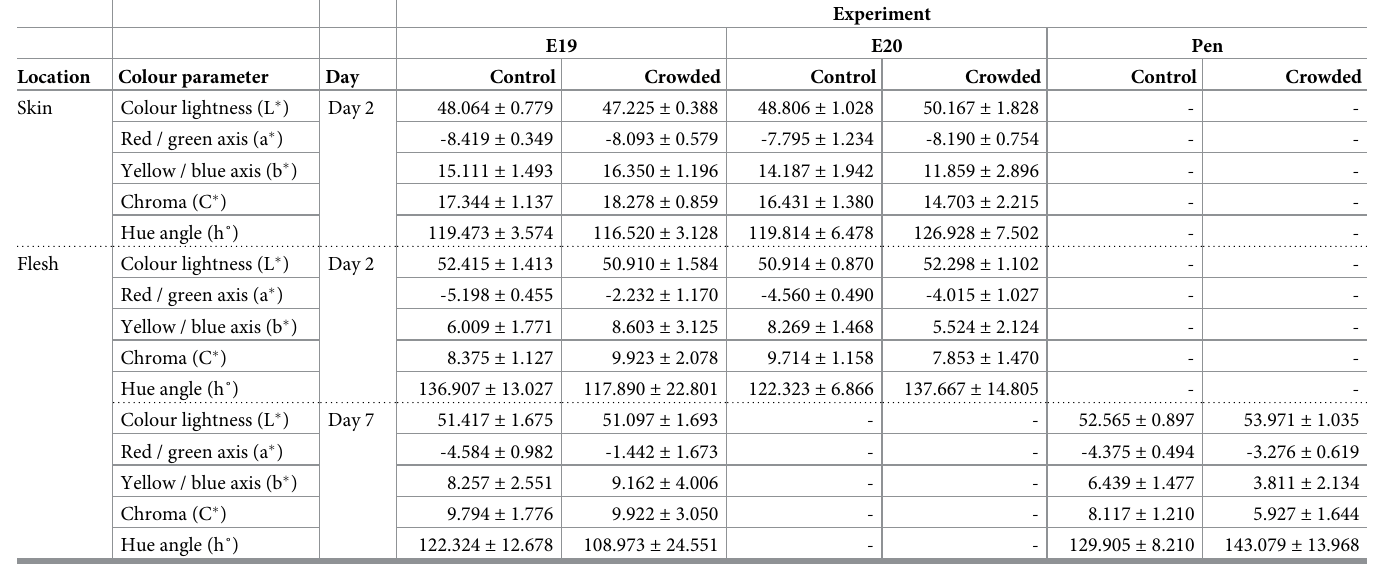
ments (Table 4). Although there were significant differences in some colour parameters Table 4. Colour parameter values in response to crowding in Atlantic mackerel skin and flesh. Colour was determined photometrically either two (“Day 2”) or seven (“Day 7”) days after death, in terms of CIELAB colour space. Values indicate mean ± 95% confidence